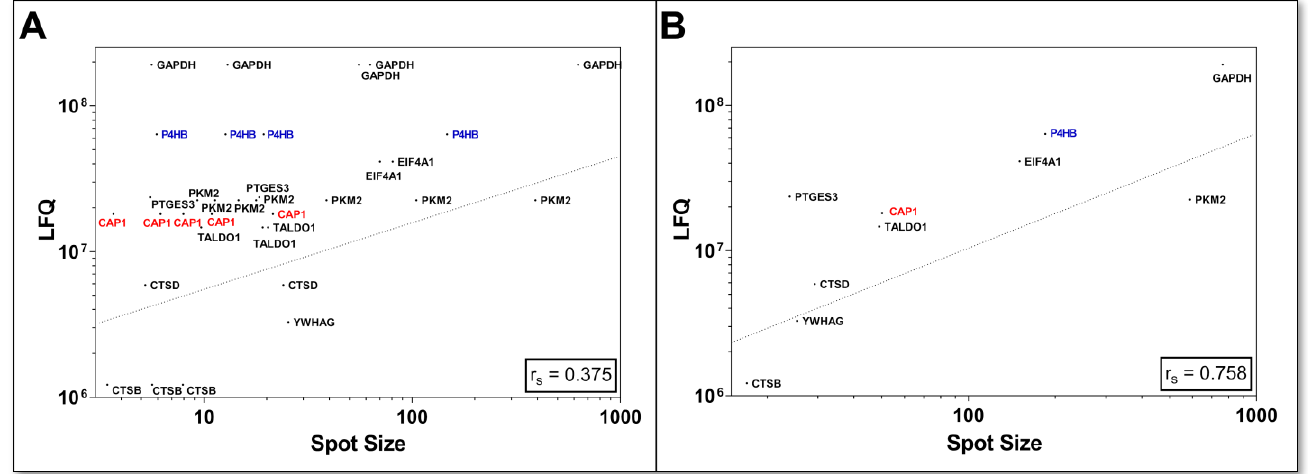
Figure 5. Correlations of quantitative data output from top-down and bottom-up methods. The red and blue proteoforms and canonical proteins are highlighted examples of different quantifications in top-down and bottom-up proteomics. ( A ) The Spearman Correlation factor without summing the abundance of the 2D spot proteoforms ( n = 34) from the same canonical protein is r S = 0.375, and ( B ) with summing the abundance of 2D spot proteoforms ( n = 85) from the same canonical protein r S = 0.758.